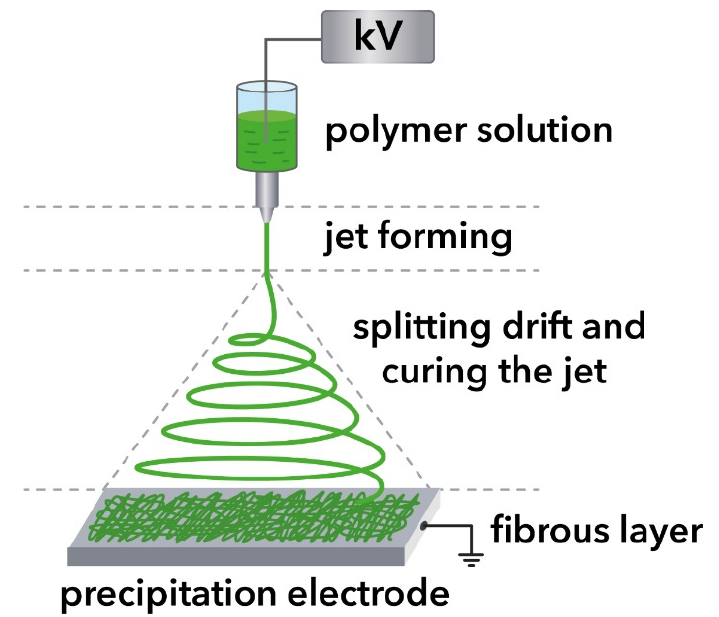
Figure 1. Fabrication of electrospinning of fibers.